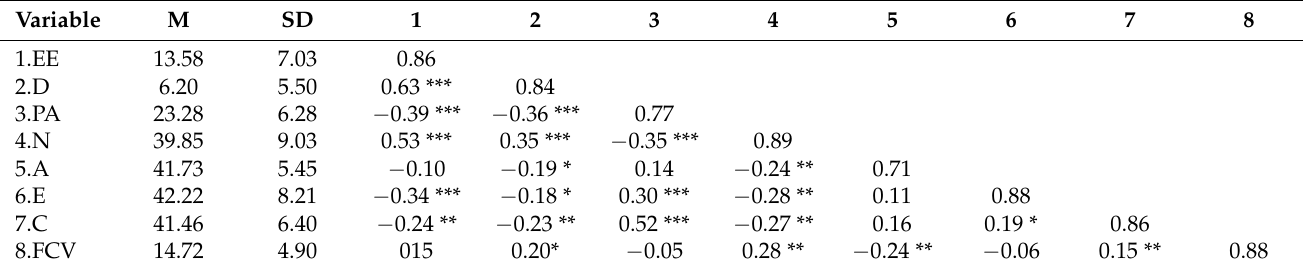
Table 1. Descriptive statistics and correlations for the study variables (N = 134).